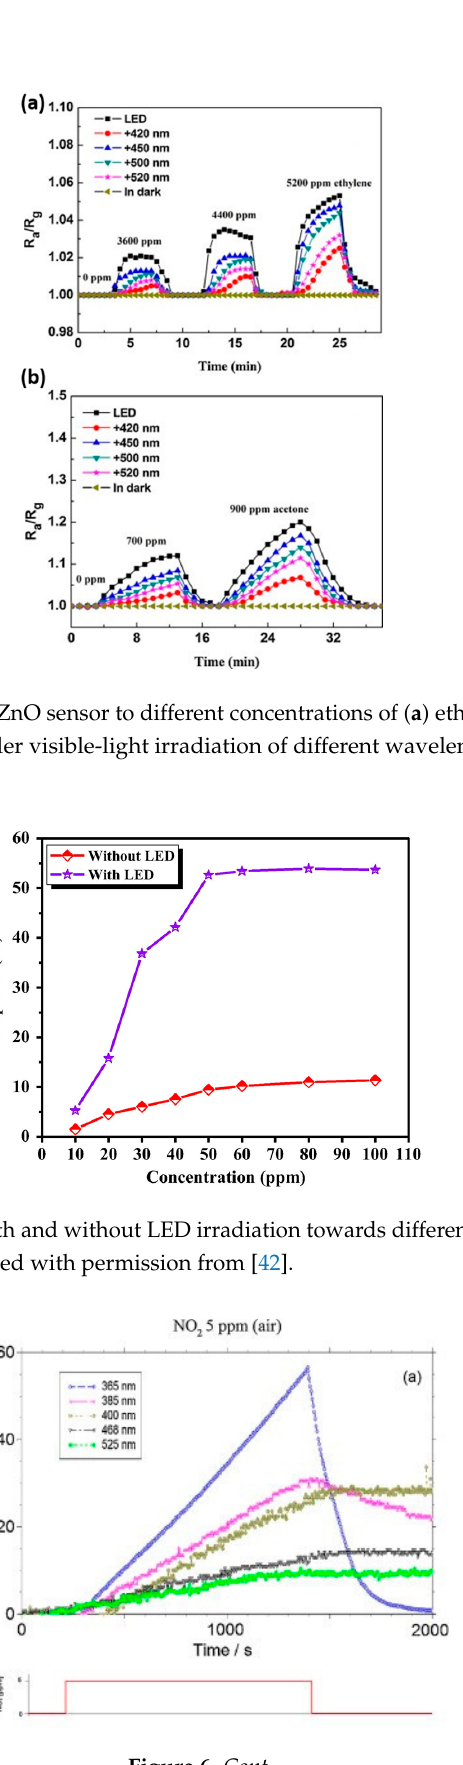
Figure 6. 5 ppm NO 2 sensing plot of ZnO thin film at room temperature as a function of ( a ) light wavelength; ( b ) background gas. Reproduced with permission from [9].